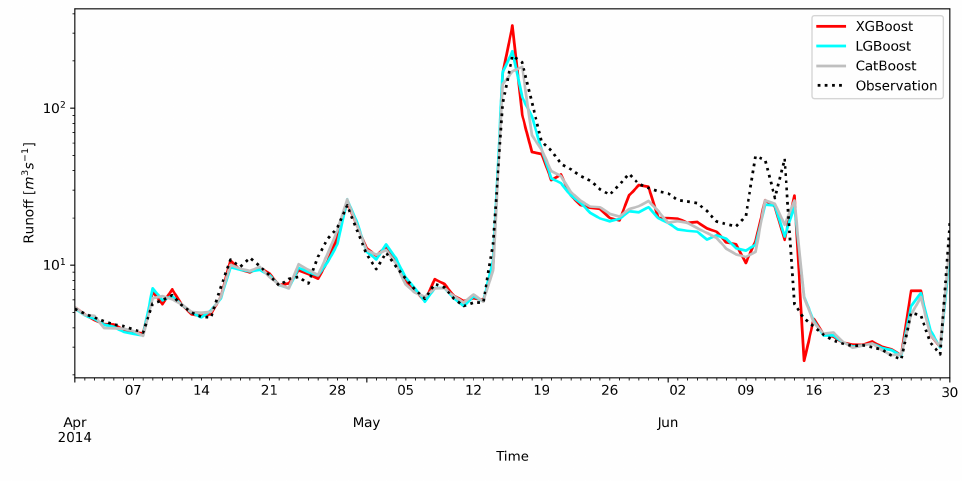
Figure 10. Daily runoff forecast for Wadowice on Skawa River—XGBoost performance problems. Usually the wave peak time is well predicted, but there are episodes where all models have problems. On average flows from the summer of 2014, individual models generate forecasts that differ from the observational data (Figure 11). The individual waves will appear, but they are shifted in time. The forecasted rising wave from the end of July has completely different dynamics than the observed